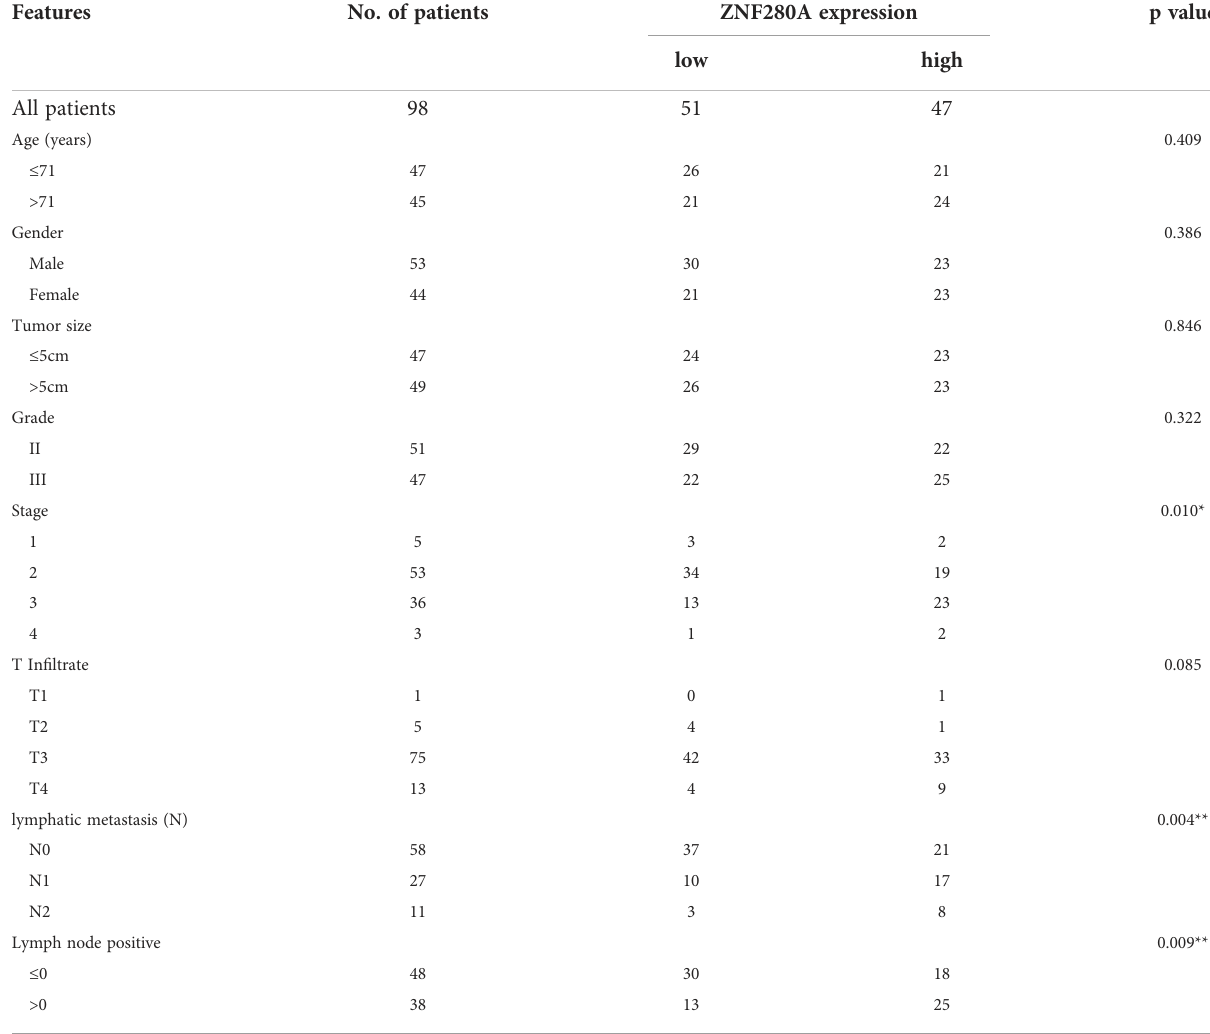
TABLE 2 Correlation of ZNF280A expression with clinical pathological characteristics in patients with colorectal cancer. Features